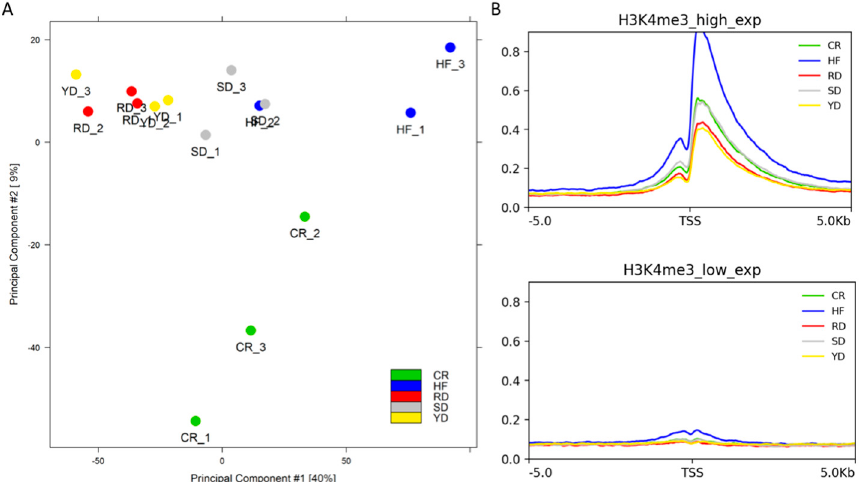
Figure 3. Heterogeneity of samples and average signal on the TSSs of the different diets: ( A ) PCA of all the samples analyzed, labelled by different colours following to the different dietary groups as indicated. ( B ) Average signal level found on the TSSs of 1000 high-expressed genes (upper panel) and 1000 low-expressed genes (lower panel).